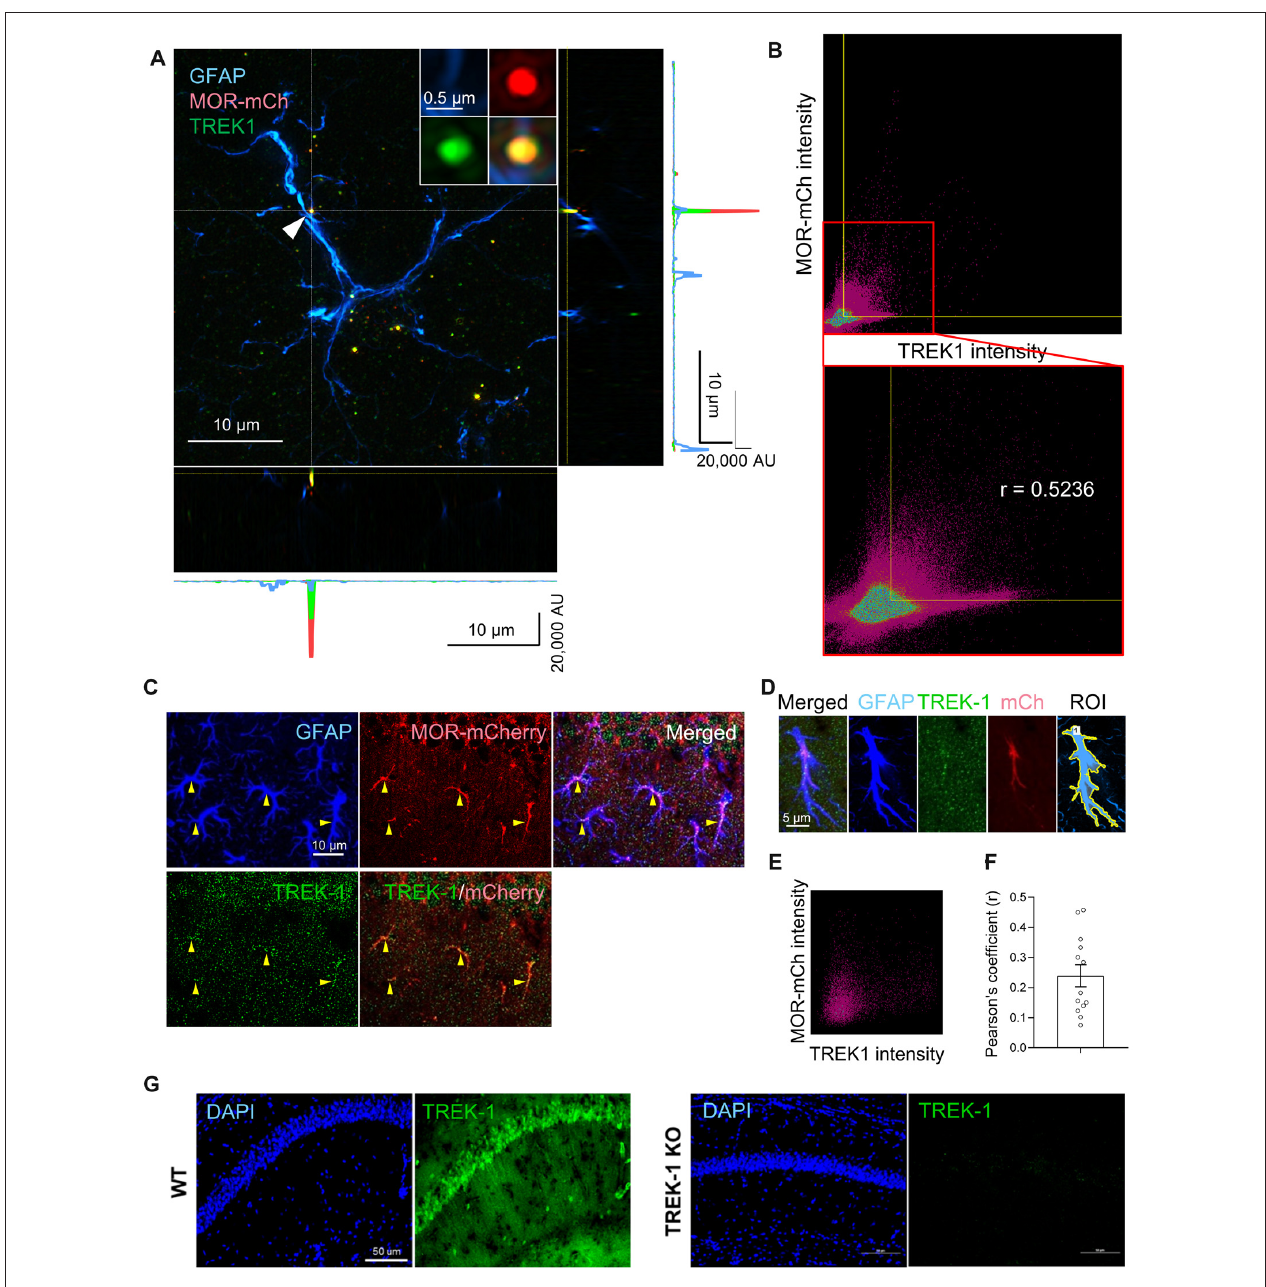
FIGURE 4 | MOR and TREK-1 are co-expressed in hippocampal astrocytes of MOR-mCherry mouse. (A) A structured illumination microscopic (SIM) image of a hippocampal astrocyte of MOR-mCherry mouse, immunostained with antibodies against GFAP and TREK-1. (B) 2D histogram of mCherry intensity and TREK-1 intensity in the SIM image (A) . Pearson’s coefficient (r) is calculated within the colocalized pixels which were automatically thresholded by Imaris 9.2 program. (C) Representative confocal images of co-localization of MOR-mCherry and TREK-1 in astrocytes in hippocampal cornu ammonis 1 (CA1) of MOR-mCherry mice. (D) An example of ROI generation within a single astrocyte. (E) Representative 2D histogram of mCherry intensity and TREK-1 intensity in the confocal image. (F) Pearson’s coefficients (r) between mCherry and TREK-1 from confocal images of single astrocytes. (G) A confocal image of hippocampal tissues from WT and TREK-1 KO mice, stained with an antibody against